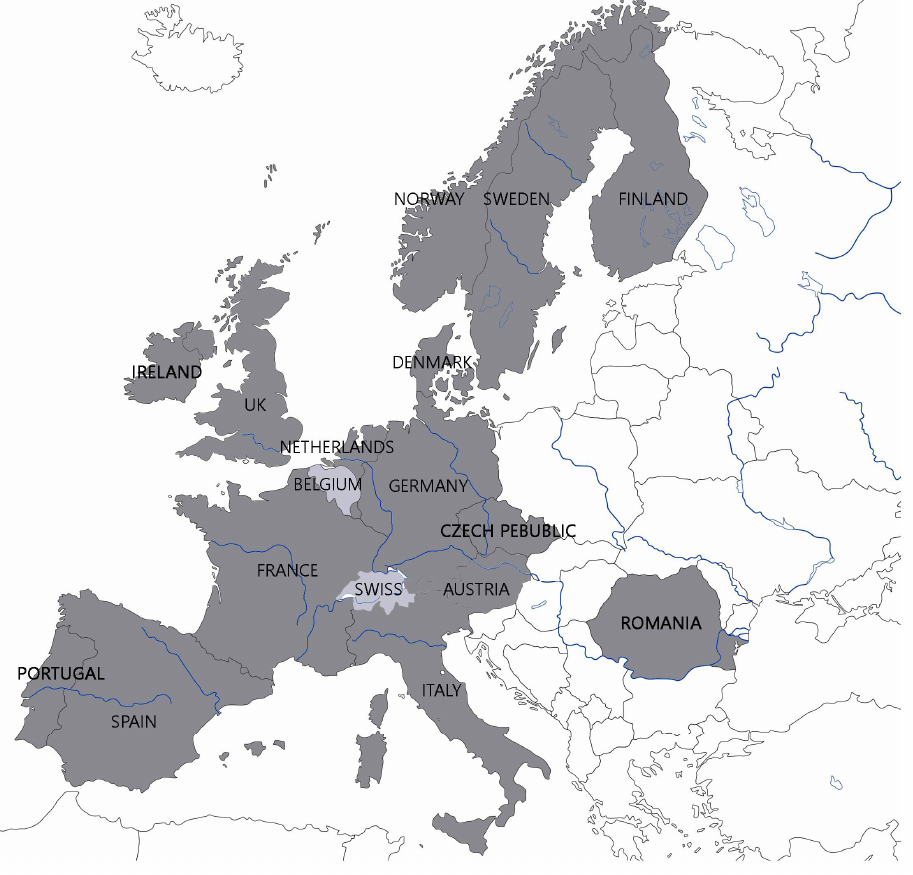
Figure 5. State of BIM adoption in 2021: top 7 countries compared. Furthermore, in 2019, a study of the same type was repeated and showed exponential evolution [31] (see Figure 6).